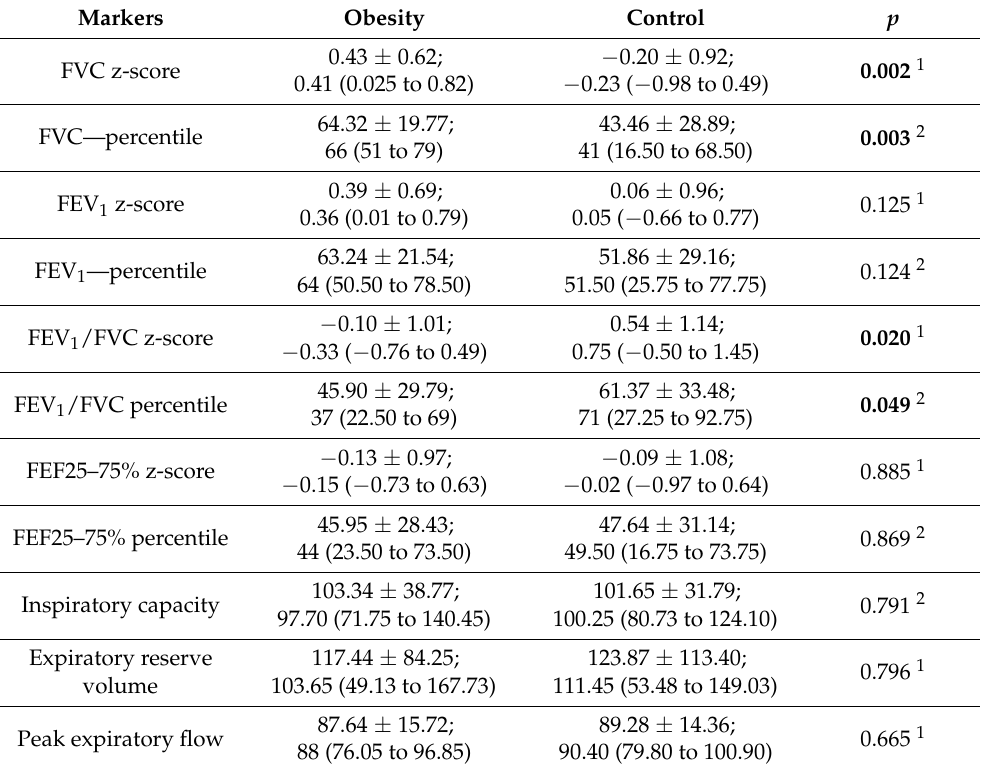
Table 5. Differences between pulmonary function markers in groups of participants with and without